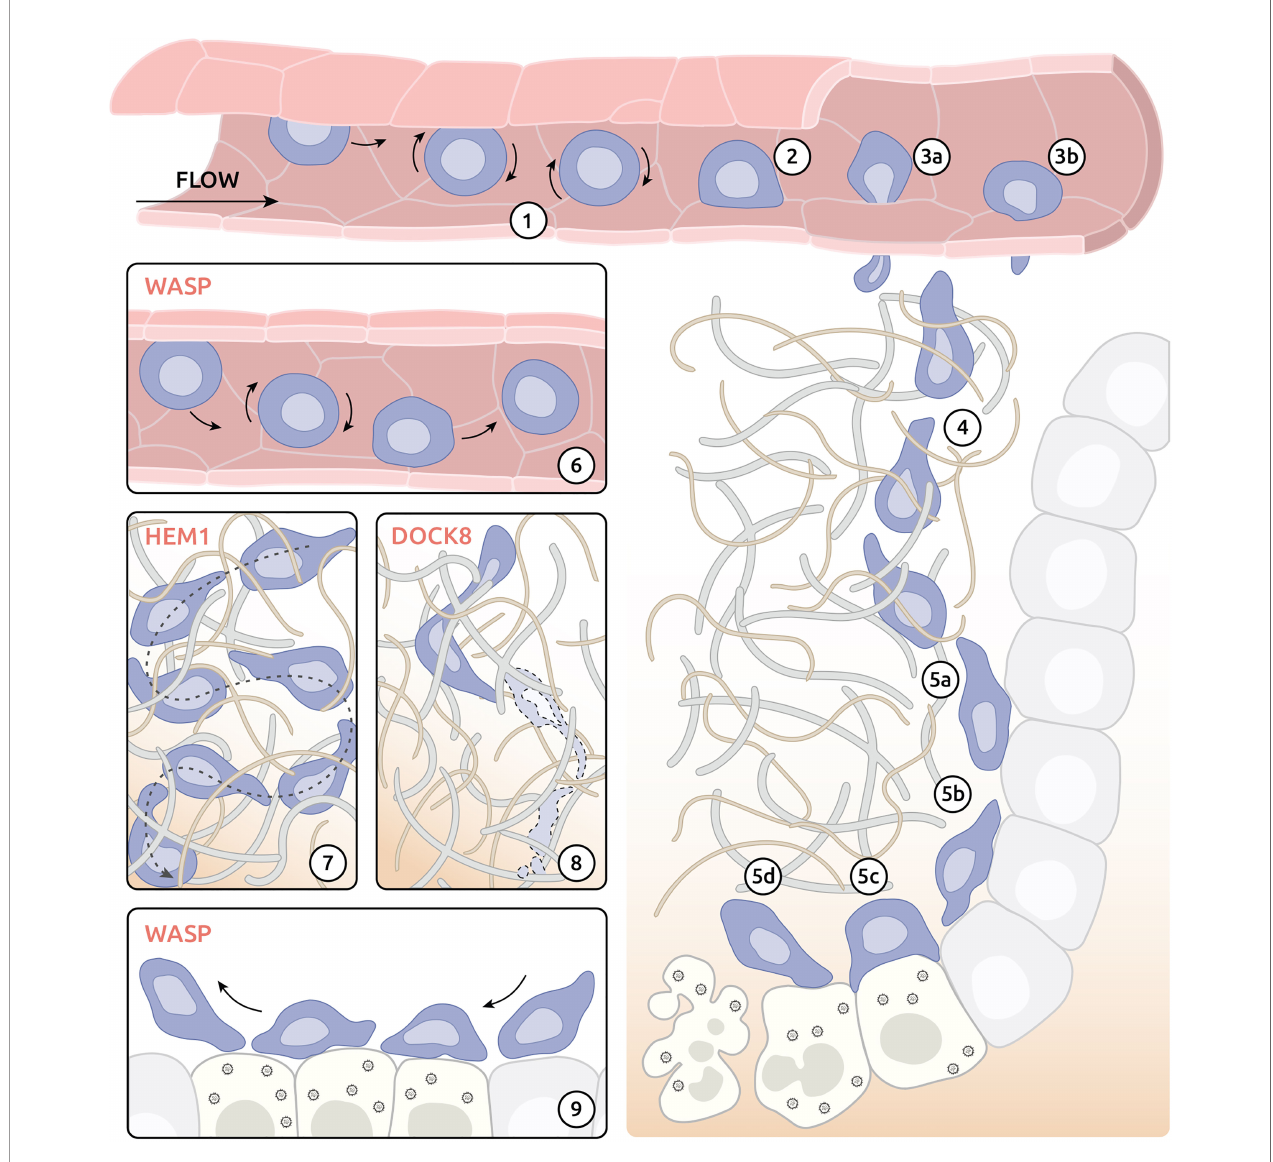
FIGURE 2 | Migratory challenges and actinopathy-associated defects of effector CD8 + T cells on the tissue level. (1) Weak adhesion (rolling) of effector T cells after interaction with activated endothelium. (2) Adhesion at the site of exit. (3) Exit of the blood vessel by migration between (3a) or through (3b) endothelium cells. (4) Interstitial navigation following chemokine gradient. (5) Execution of cytolytic activity at the site of infection. (5a) Interaction with target cells. (5b) Kynapse-based scanning of target cells. (5c) Development of IS with infected cells and delivery of cytotoxic compounds. (5d) Destabilization of immune synapse (IS) and detachment from targeted cell. (6) Compromised attachment of WASP-de fi cient T cells to the endothelium at the exit site. (7) Reduced capacity of directional migration in tissue environment of HEM1-de fi cient T cells. (8) Cytothripsis of DOCK8-de fi cient T cells during migration through con fi ned environment. (9) Impaired formation of IS by WASP-de fi cient T